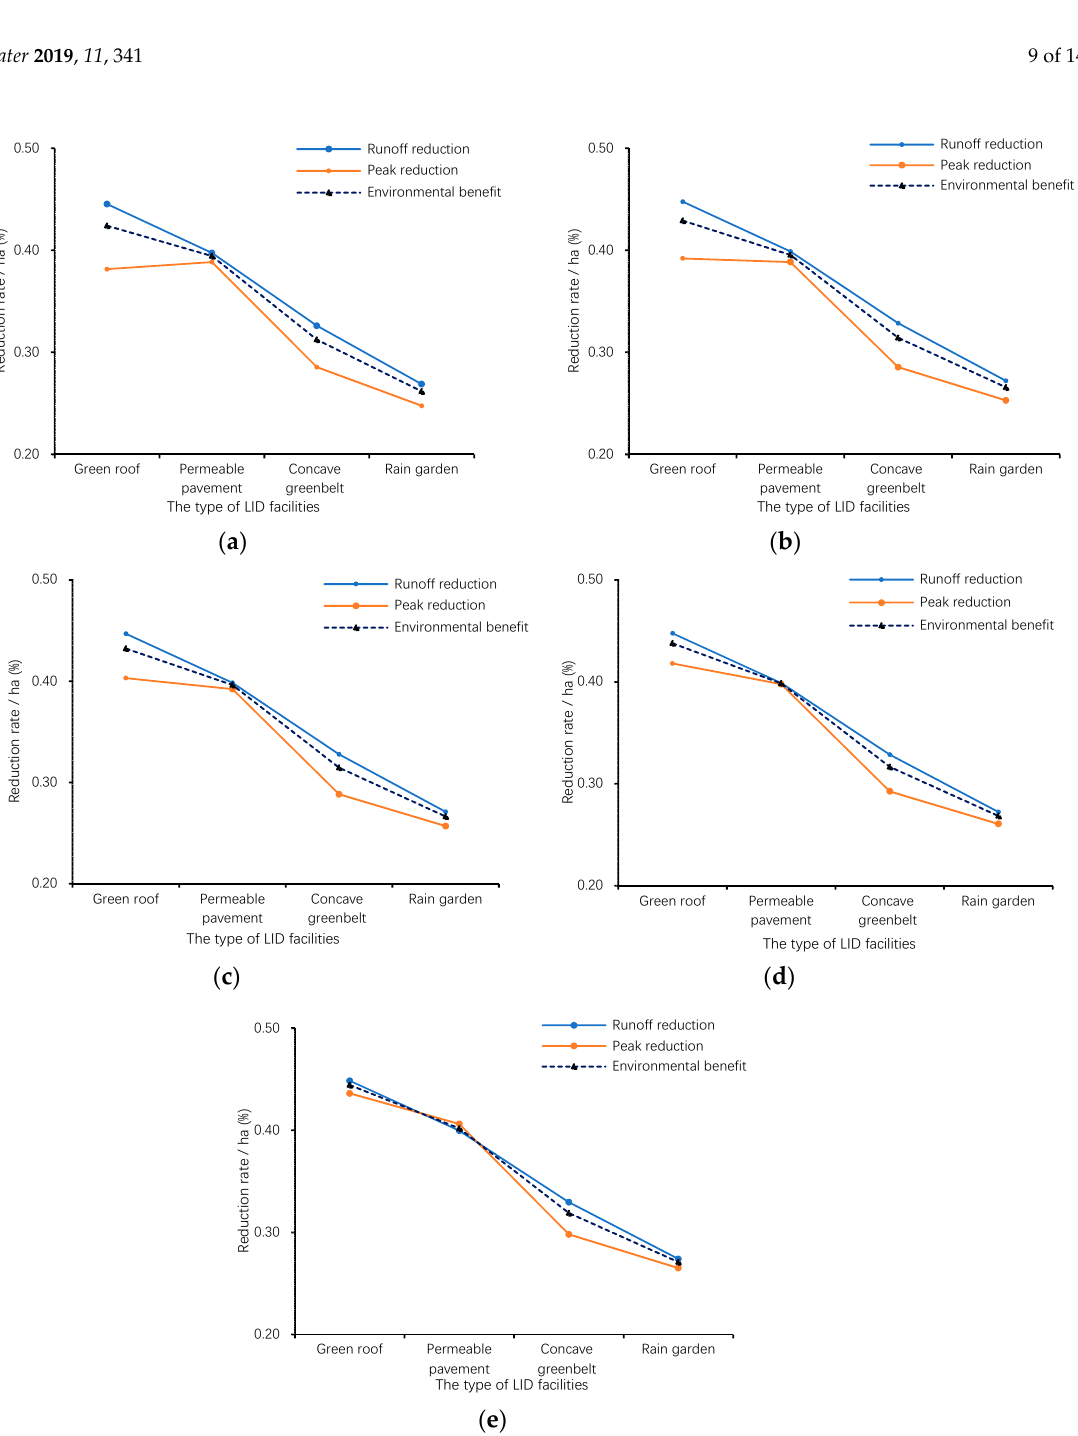
Figure 5. Hydrological effectiveness of each LID technique per unit area (note: environmental benefit = 0.667 × runoff reduction + 0.333 × peak reduction). ( a ) Runoff reduction rates of the LID technique when the LID proportion of maximum construction area was set at 20% (column 3 of Tables 7 and 8); ( b ) runoff reduction rates of the LID technique when the LID proportion of maximum construction area was set at 40% (column 4 of Tables 7 and 8); ( c ) runoff reduction rates of the LID technique when the LID proportion of maximum construction area was set at 60% (column 5 of Tables 7 and 8); ( d ) runoff reduction rates of the LID technique when the LID proportion of maximum construction area was set at 80% (column 6 of Tables 7 and 8); ( e ) runoff reduction rates of the LID technique when the LID proportion of maximum construction area was set at 100% (column 7 of Tables 7 and 8).